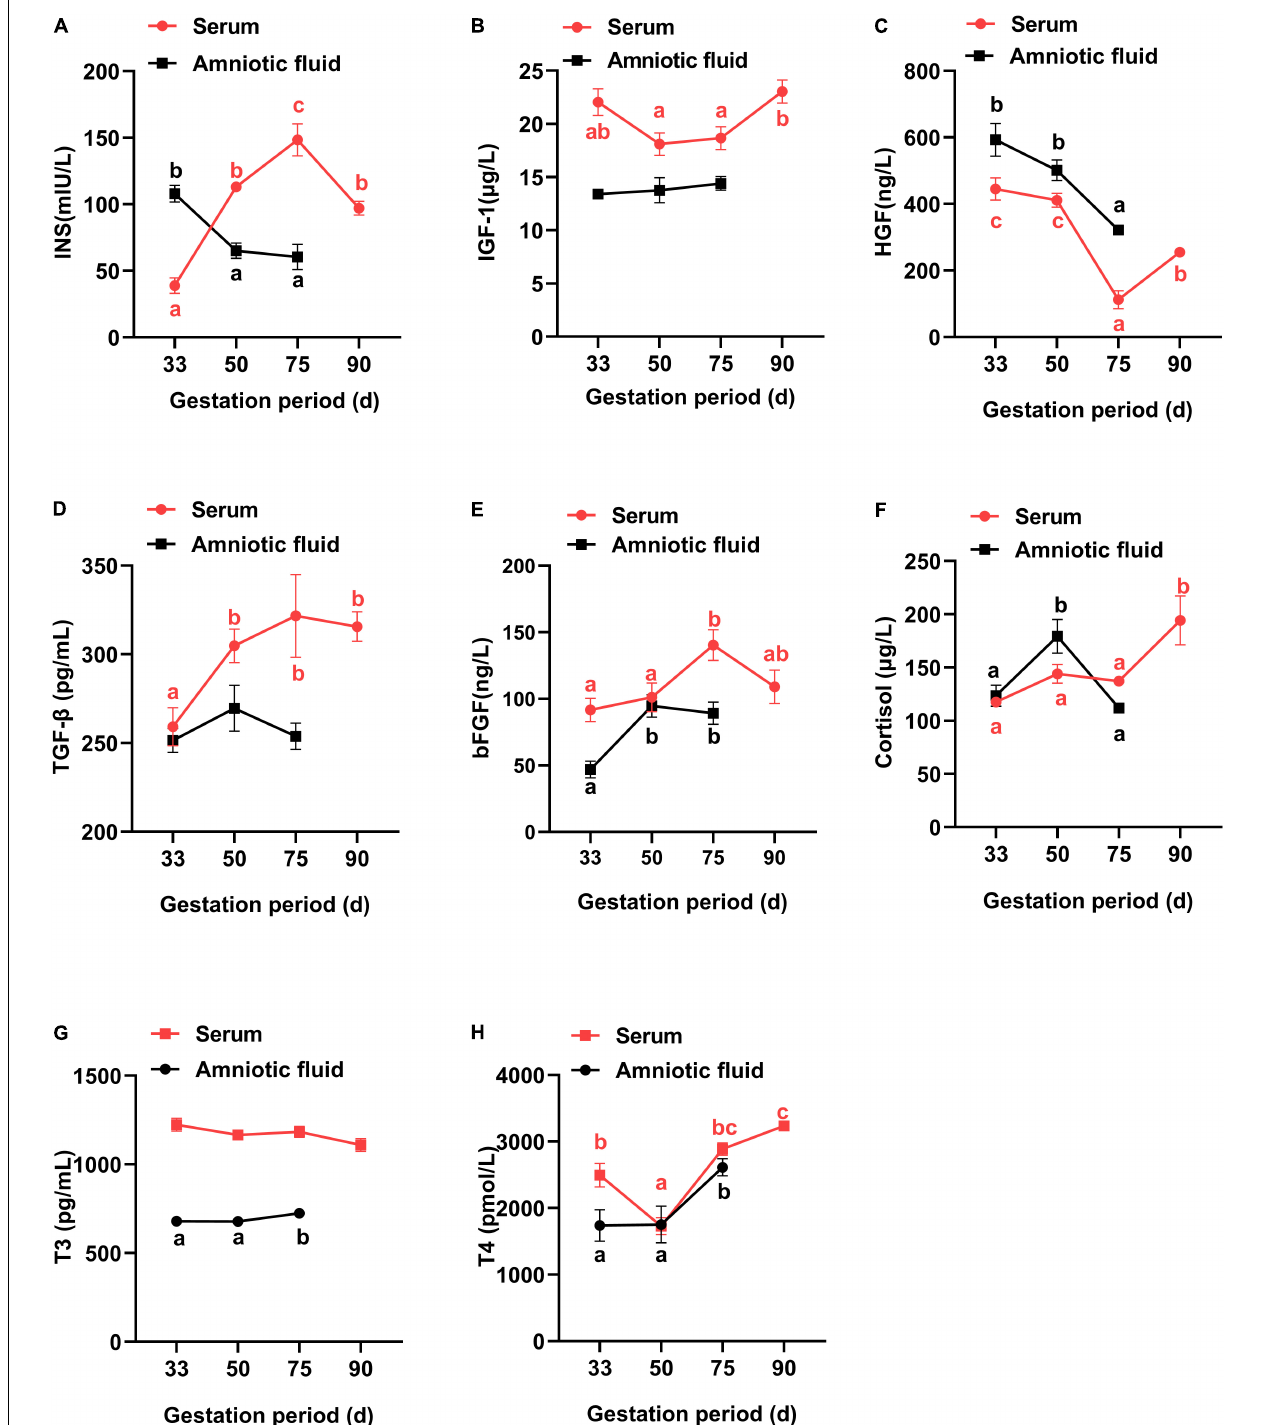
FIGURE 2 | Changes of physiological hormones in the serum and amniotic fluid of Tibetan sows at different gestation periods. (A) INS; (B) IGF-1; (C) HGF; (D) TGF- β ; (E) bFGF; (F) Cortisol; (G) T3; (H) T4. Data are expressed as mean ± SEM ( N = 3); INS, insulin; IGF-1, insulin-like growth factor 1; HGF, hepatocyte growth factor; TGF- β , transforming growth factor β ; bFGF, basic fibroblast growth factor; T3, triiodothyronine; T4, thyroxine. Different lowercase letters represent significant difference at P < 0.05.